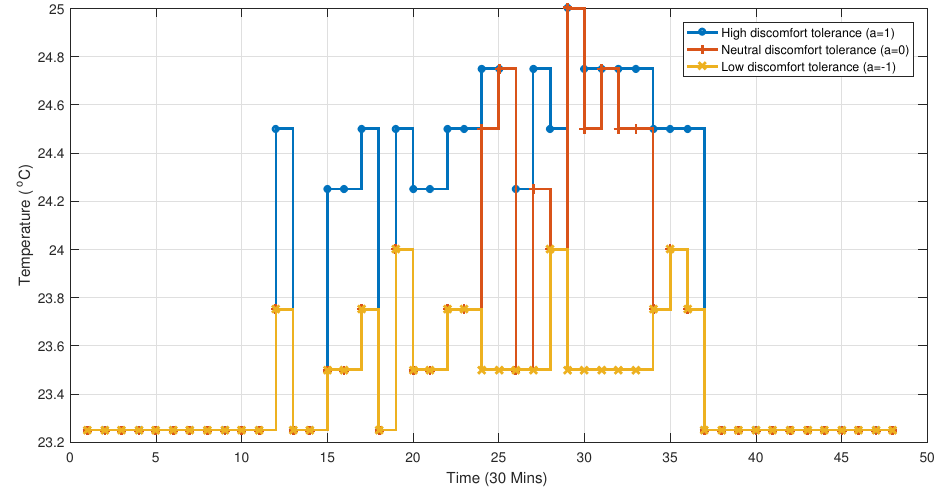
Figure 8. Temperature set point for uncertain basis method.